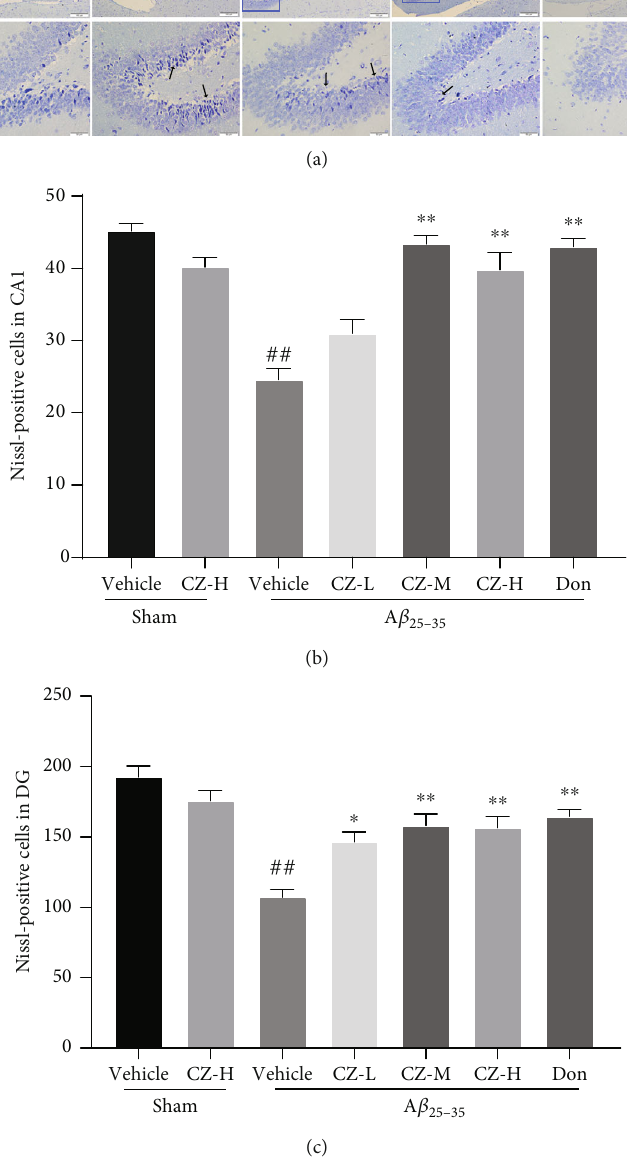
Figure 2: CZYH mitigates A β -induced neuronal loss in rats. (a) Nissl staining of hippocampus CA1 and DG regions (scale bar: 100 μ m 25-35 and 50 μ m). (b, c) Quantitative analysis of Nissl bodies in (b) the CA1 hippocampal region and (c) the DG hippocampal region. Values are means ± SEM , n = 5 . ## P < 0 : 01 vs. sham; ∗ P < 0 : 05 and ∗∗ P < 0 : 01 vs. A β 25-35